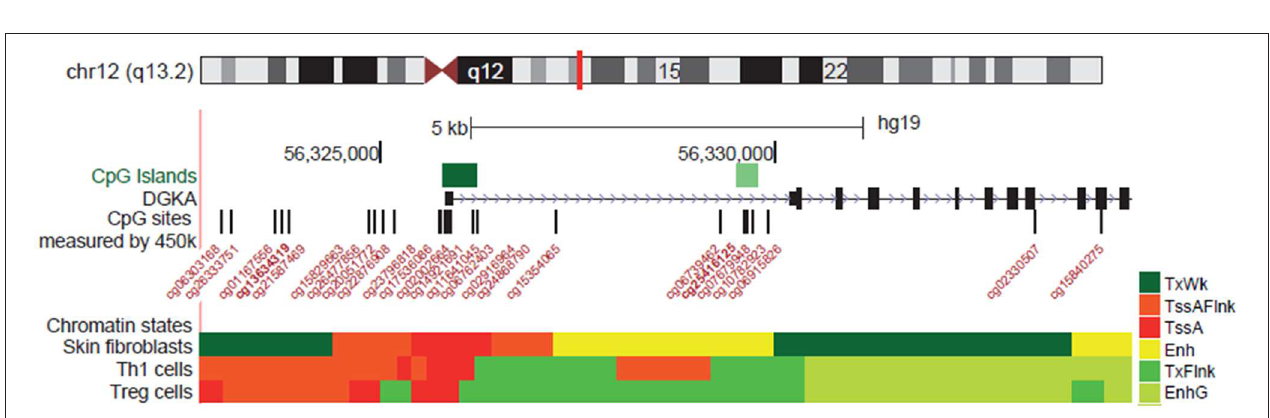
FIGURE 2 | DGKA expression in normal human tissues. (A) The 10 tissues with the highest DGKA RNA expression are shown. Data are derived from a consensus dataset in the Human Protein Atlas (HPA) which combines data from three comprehensive databases (HPA, GTEx, and FANTOM5). (B) DGKA protein expression measured by immunohistochemistry in cell types present in the tissue with the highest RNA expression shown in (A) . Protein data for thymus and T cells were not included in the HPA protein database. For details of protein expression, normalization and quantification, see website (https://www.proteinatlas.org/ ENSG00000065357-DGKA/tissue).